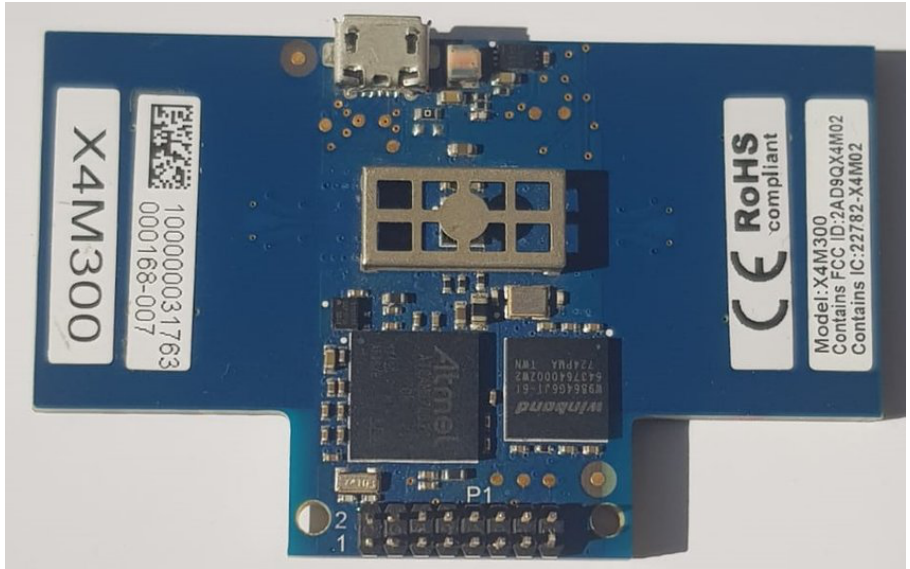
Figure 2. X4m300 UWB